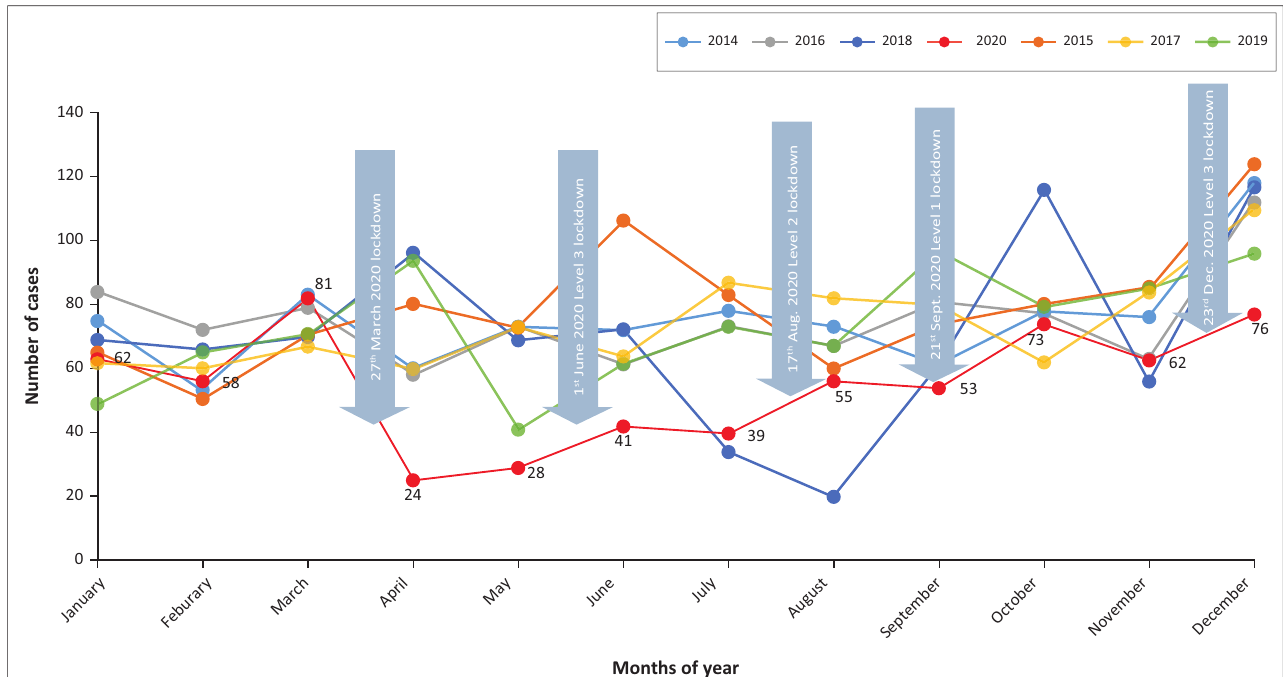
FIGURE 2: Monthly distribution of sexual assault cases at Sinawe Thuthuzela Care Centre,